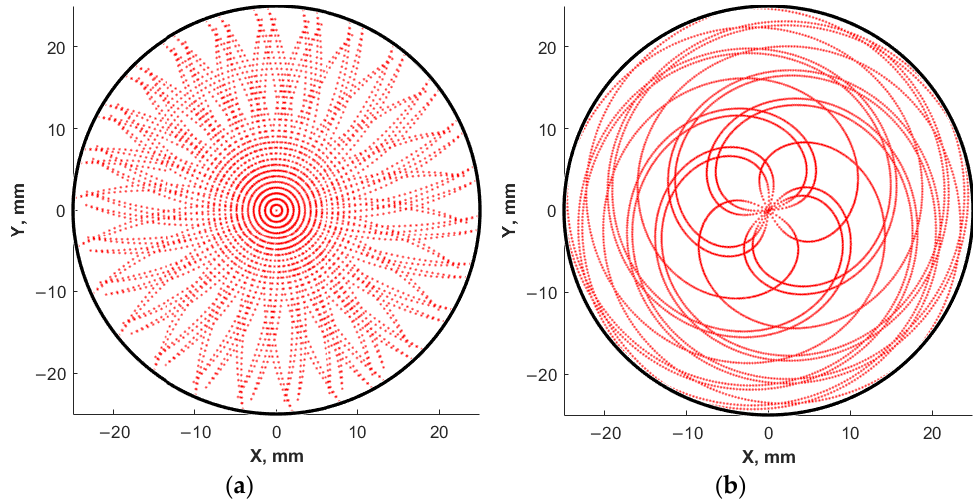
Figure 3. Trajectories of the laser beam movement along the target surface: scanning mode by the target with a stationary laser beam ( a ); scanning mode of the laser beam along the surface of a rotating target ( b ).